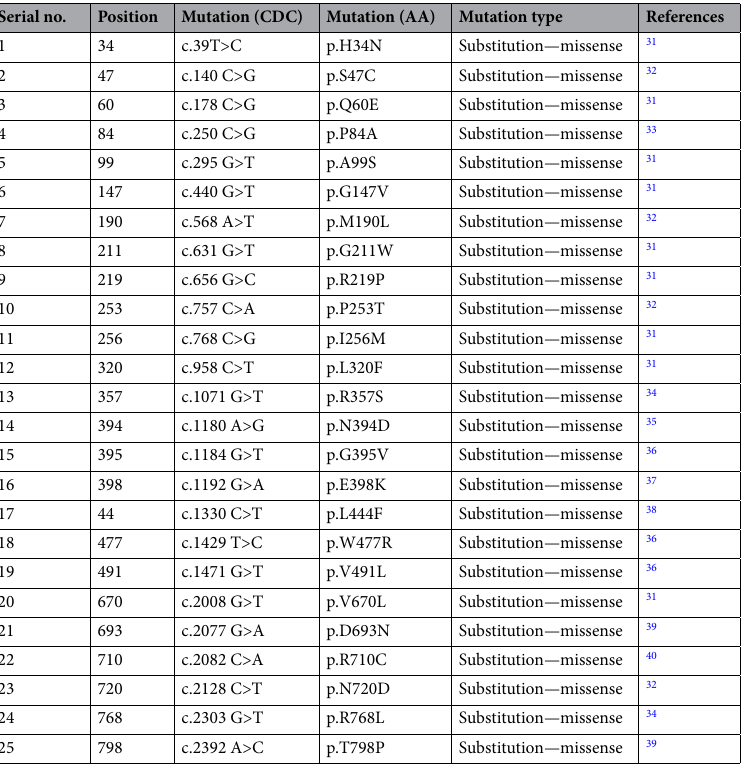
Table 1. Mutations for the ACE2 gene curated from the COSMIC